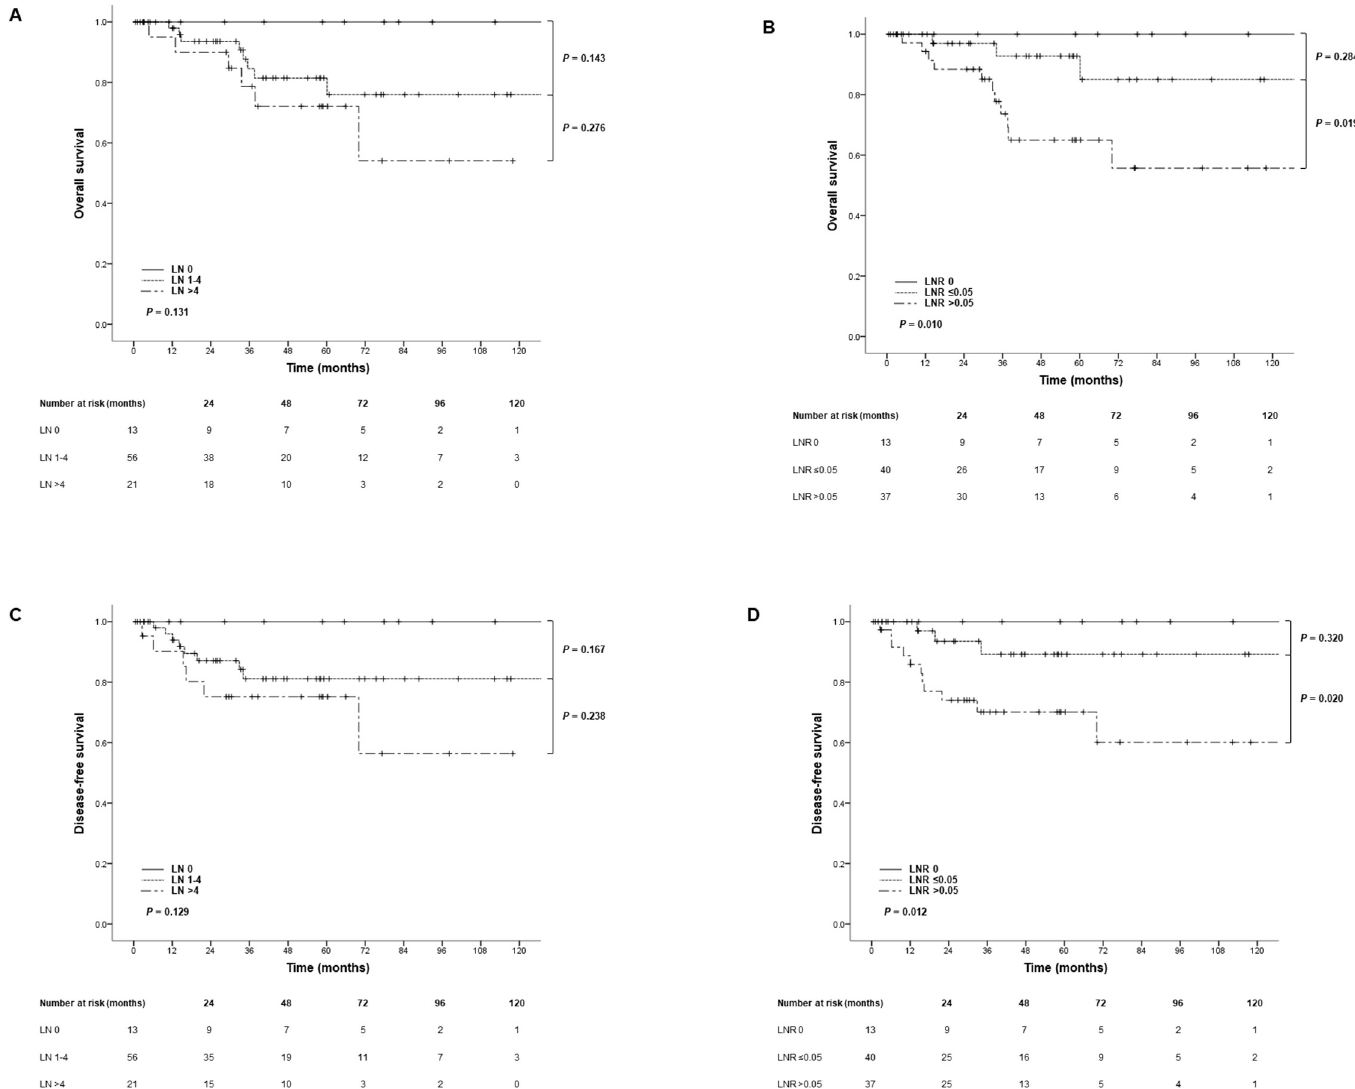
Fig 2. Kaplan-Meier curves of overall survival (OS) (A, B) and disease-free survival (DFS) (C, D) according to lymph node numbers and ratios.